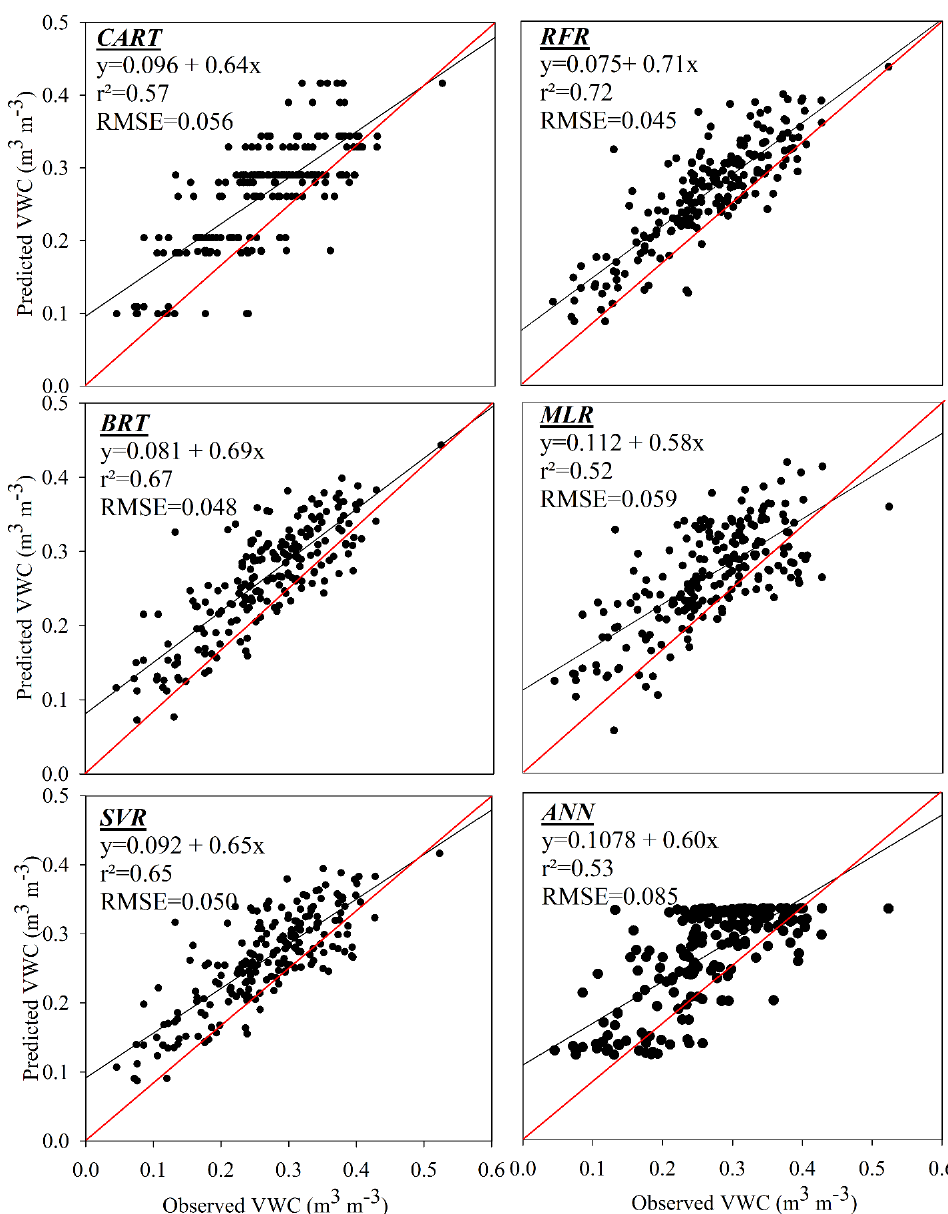
Figure 2. Scatter plots showing observed versus predicted volumetric water content (m 3 m − 3 ) during the testing phase along with regression coefficient (r 2 ) and root mean square error (RMSE) for 6 different machine learning models. Algorithms included classification and regression trees (CART), multiple linear regression (MLR), random forest regression (RFR), support vector regression (SVR), boosted regression trees (BRT), and artificial neural networks (ANN).